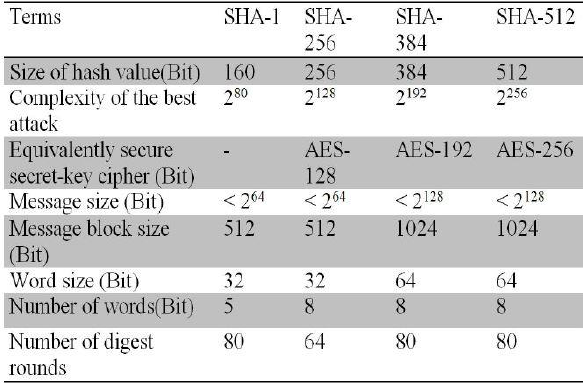
Figure 3. Break the encryption block into smaller matrices Figure 1. Functional characteristics of four investigated Hash function (Seyedzade, 2011) Now, according to the acquired parameters, the blocks of each of the maps are formed and then, to increase the safety factor, these blocks are combined together with the help of the XOR key to form the end encryption block. Figure 4 shows chaotic maps used in the proposed algorithm.